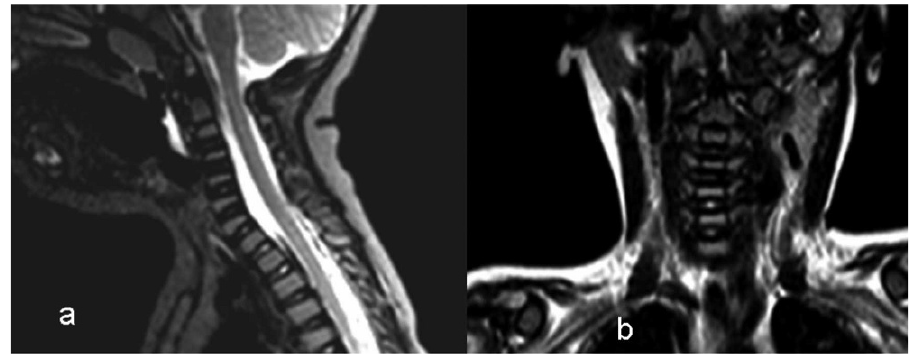
Figure 3 - Sagittal and coronal MRI imaging of the cervical spine showed no associated cervical kyphosis, although mild synchondroses of the vertebral bodies